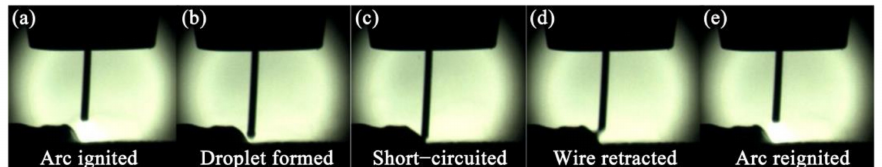
Figure 15. Phases of CMT process [153]. ( a ) arc ignited; ( b ) droplet formed; ( c ) short circuited; ( d ) wire retracted; ( e ) arc reignited.